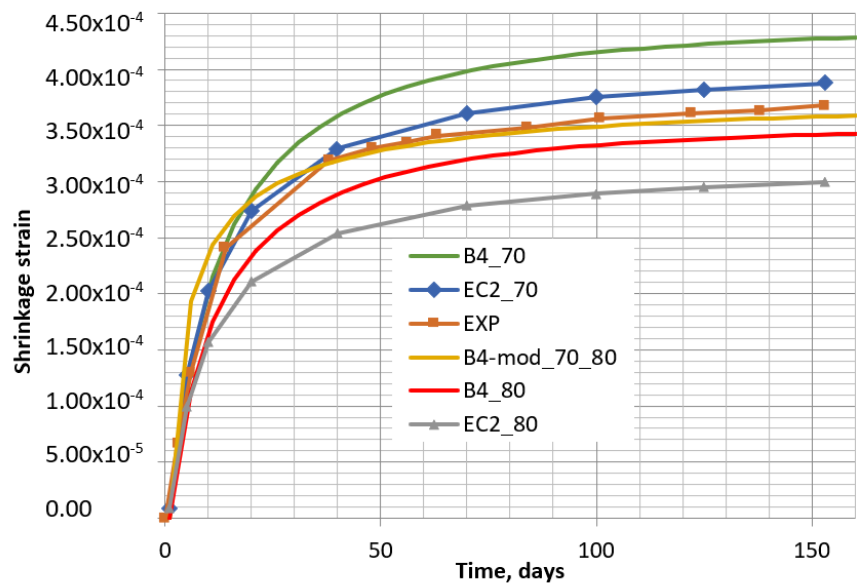
Figure 16. Shrinkage of control specimens obtained experimentally (EXP) and by methods EC2, B4, and B4-mod with 70% and 80% humidity (EC2_70, EC2_80, B4_70, B4_80, and B4-mod_70_80).